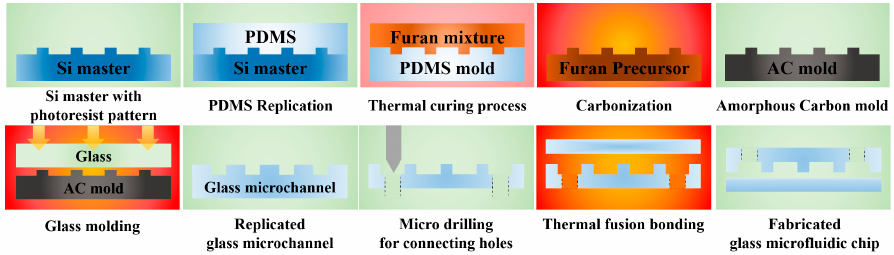
Figure 1. Schematic of the fabrication process for the AC mold by the carbonization of a replicated furan precursor and the all-glass bifurcation microfluidic chip by glass molding and thermal fusion bonding.